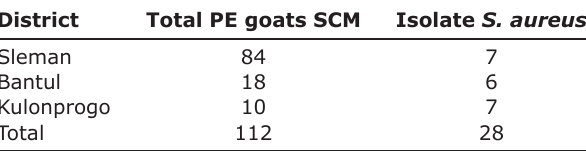
Table-2: Detection S. aureus from SCM in PE goats in Yogyakarta.